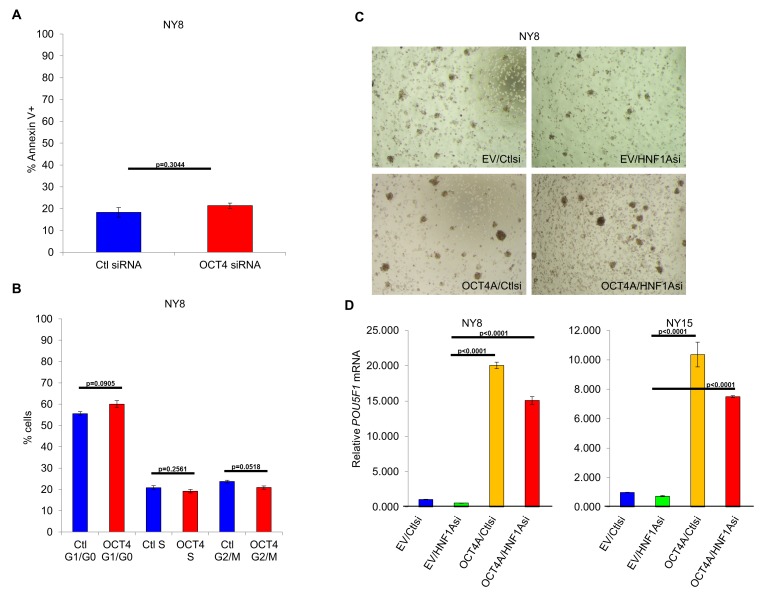
Rescue of POU5F1/OCT4 expression in PDA cells.(A, B) NY8 cells were transiently transfected with control (Ctl) or POU5F1/OCT4-targeting (labeled OCT4) siRNA for 72 hr, followed by (A) annexin V/DAPI-staining or (B) propidium iodide (PI) staining to quantitate apoptotic and cycling cells, respectively. Data is represented as the mean for each group ± SEM, (n = 3). Statistical difference between adherent and sphere cells was determined by unpaired t test with Welch's correction, and respective p values are indicated. (C) NY8 cells transduced with OCT4A or empty vector control (EV) were transiently transfected with control (Ctl) or HNF1A-targeting siRNA for 72 hr, and then grown in tumorsphere media on non-adherent plates (1500 cells/well). Representative images of tumorspheres are shown. (D) Quantitative RT-PCR for POU5F1/OCT4 transcript was measured in NY8 and NY15 empty vector (EV) or OCT4A-transduced cells transfected with control or HNF1A siRNA for 72 hr. ACTB transcript was used as an internal control, n = 3. Statistical difference was determined by one-way ANOVA with Tukey’s multiple comparisons test.